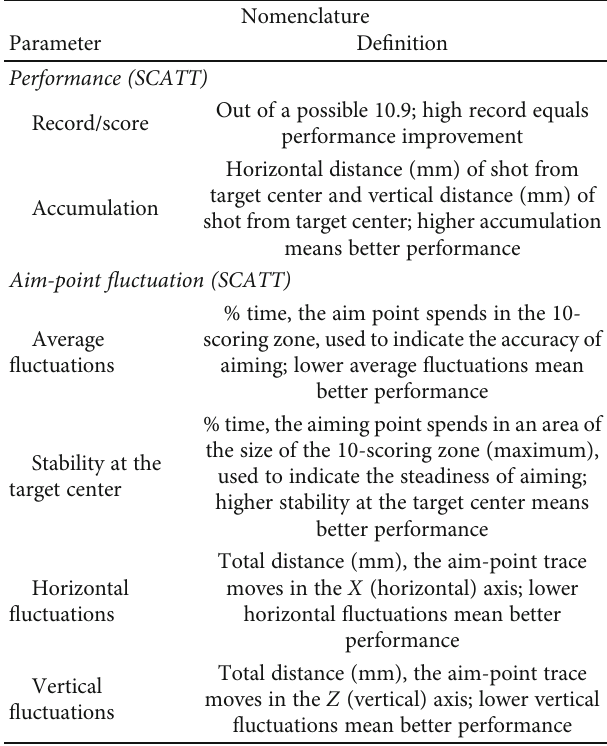
Table 1: The parameters used to indicate shooting performance and aim-point fl